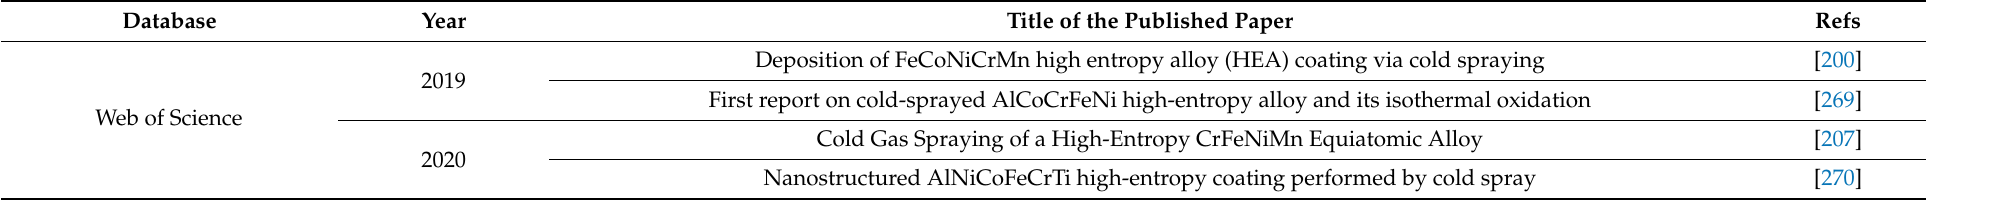
Table 9. Summary of cold spray CCA-based coatings published from 2019 to 2023 from Web of Science and